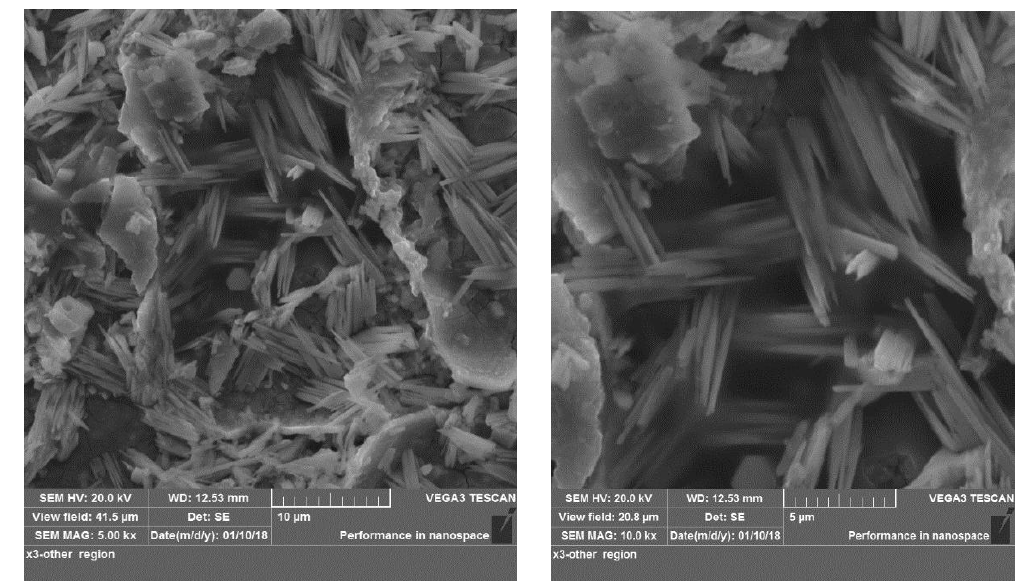
Fig. 5: SEM micrograph image for the S2